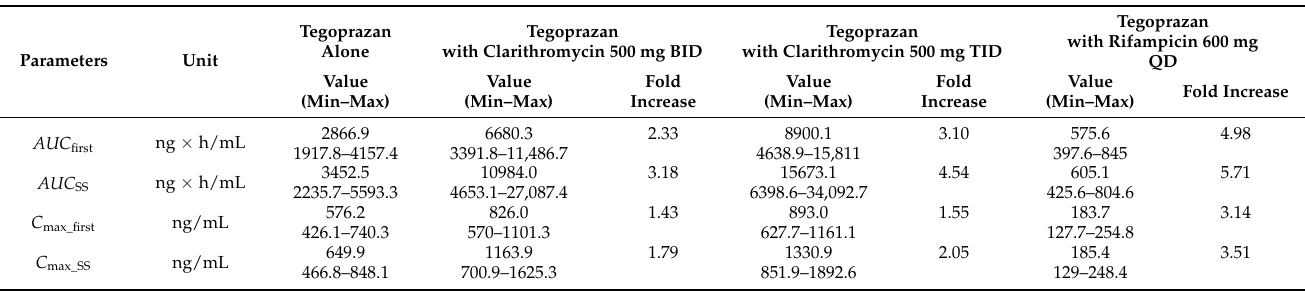
Table 3. Predicted PK parameters of tegoprazan following oral administration of tegoprazan (50 mg, BID) with CYP3A4 perpetrators.